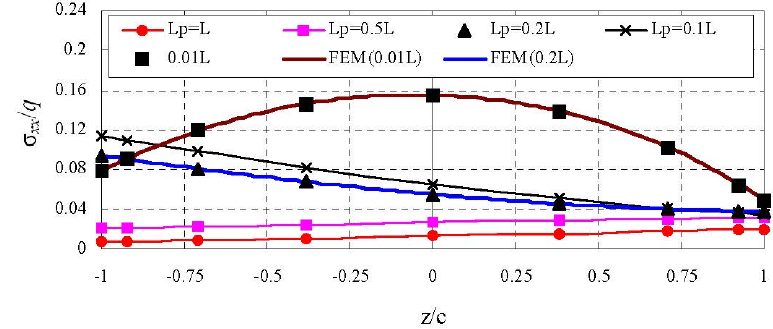
q ) of sandwich panels at x = − 0.0464 L. xx